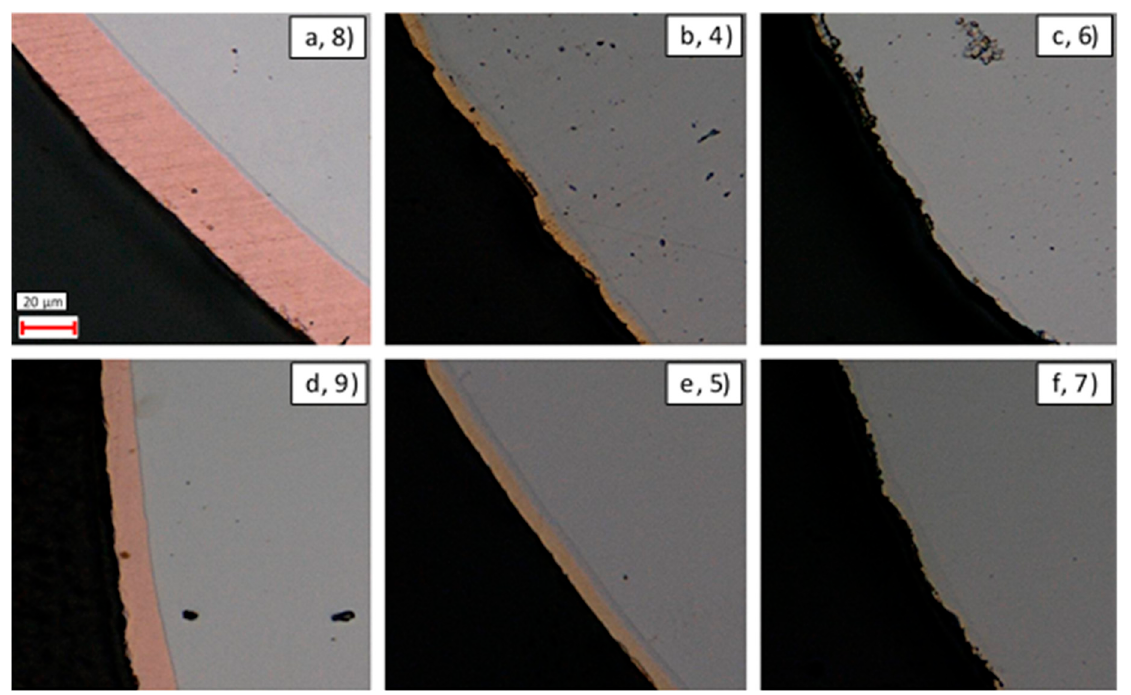
Figure 16. ×1000 magnification view of the cross-sectional surface of samples: ( a – c ) thin-walled pipes, ( d – f ) thick-walled pipes, ( a , d ) NiCu-coated, ( b , e ) NiAu-coated, ( c , f ) Ni-coated. Table 9. Qualitative ranking of the joint samples, where 1 represents the optimal characteristics sample (in green) and 6 represents the worst characteristics (in